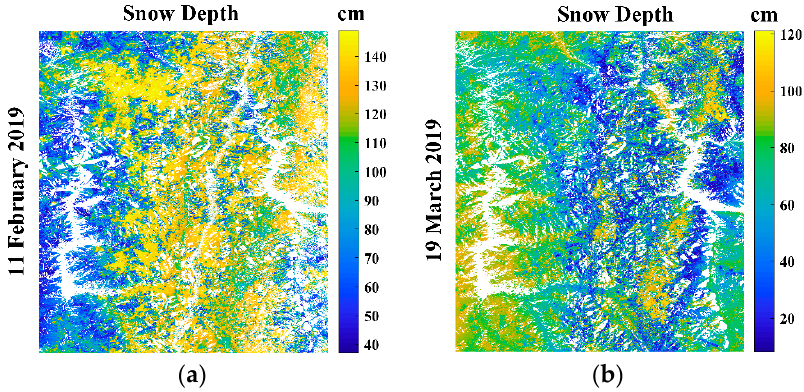
Figure 11. Spatial distribution of the estimated snow depth for 11 February 2019 ( a ) and 19 March 2019 ( b ), based on the proposed method using the Sentinel-1 datasets. Table 3. Estimated snow properties at five target station in 2019 (see Figure 1).